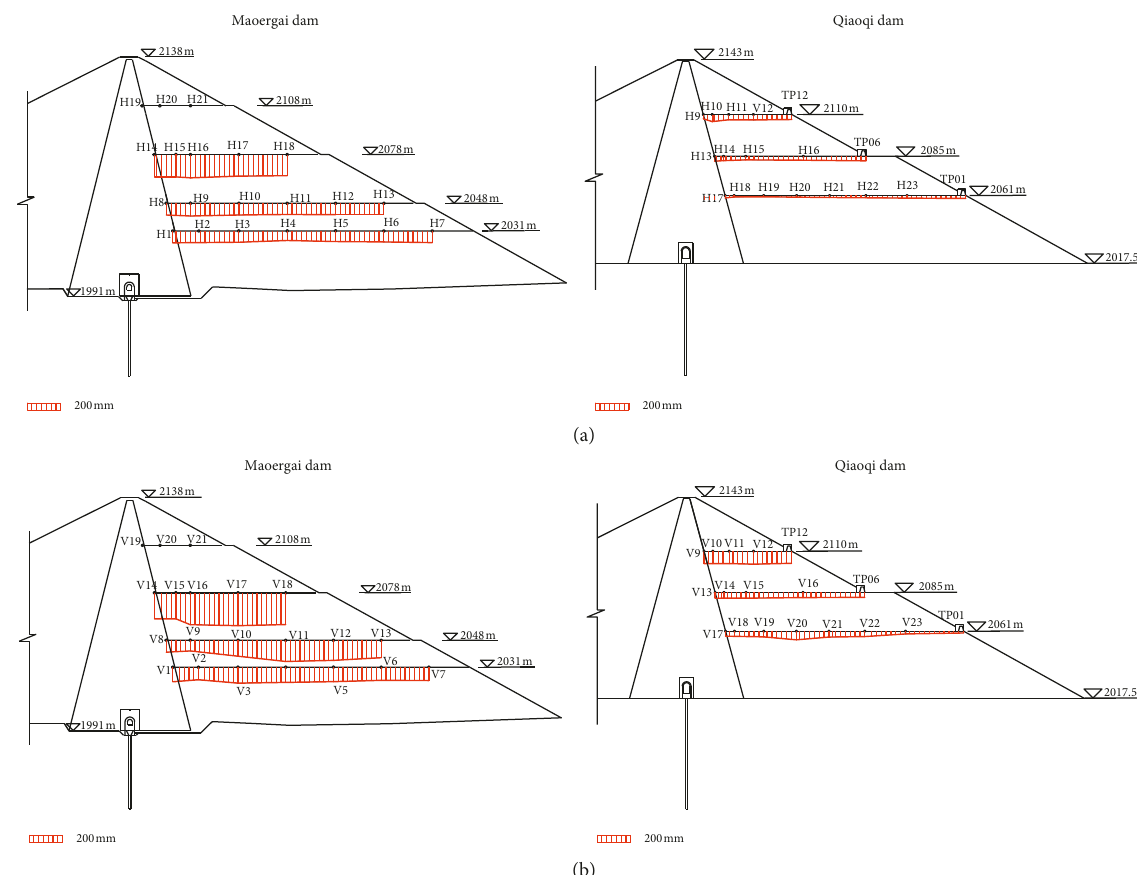
Figure 3: Postconstruction deformation developed over a period of 3.3 years. (a) Horizontal displacement in the river flow direction. (b)